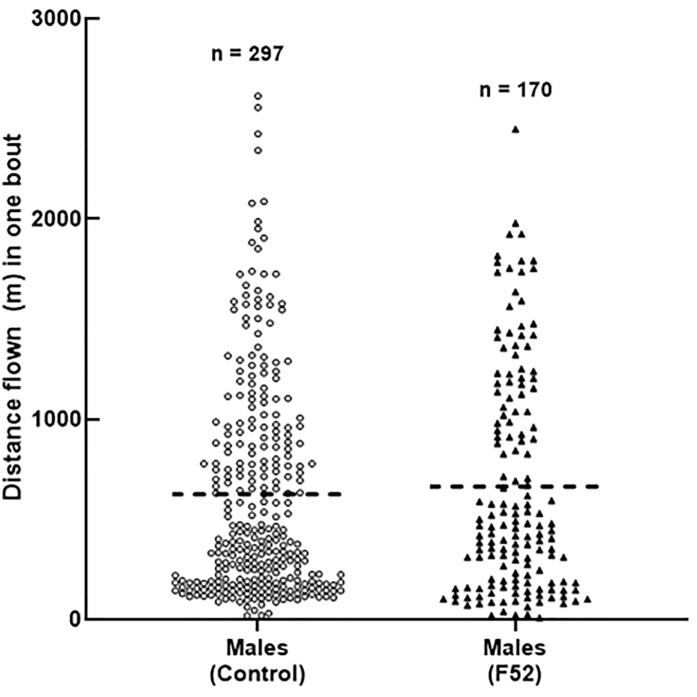
Male beetle flight bouts at 7 days after treatment.The distance flown (m) during individual flight bouts for A. glabripennis adult males, 7 days after treatment. Dotted line represents the mean. Sample size for total flight bouts is displayed above scatter plots.